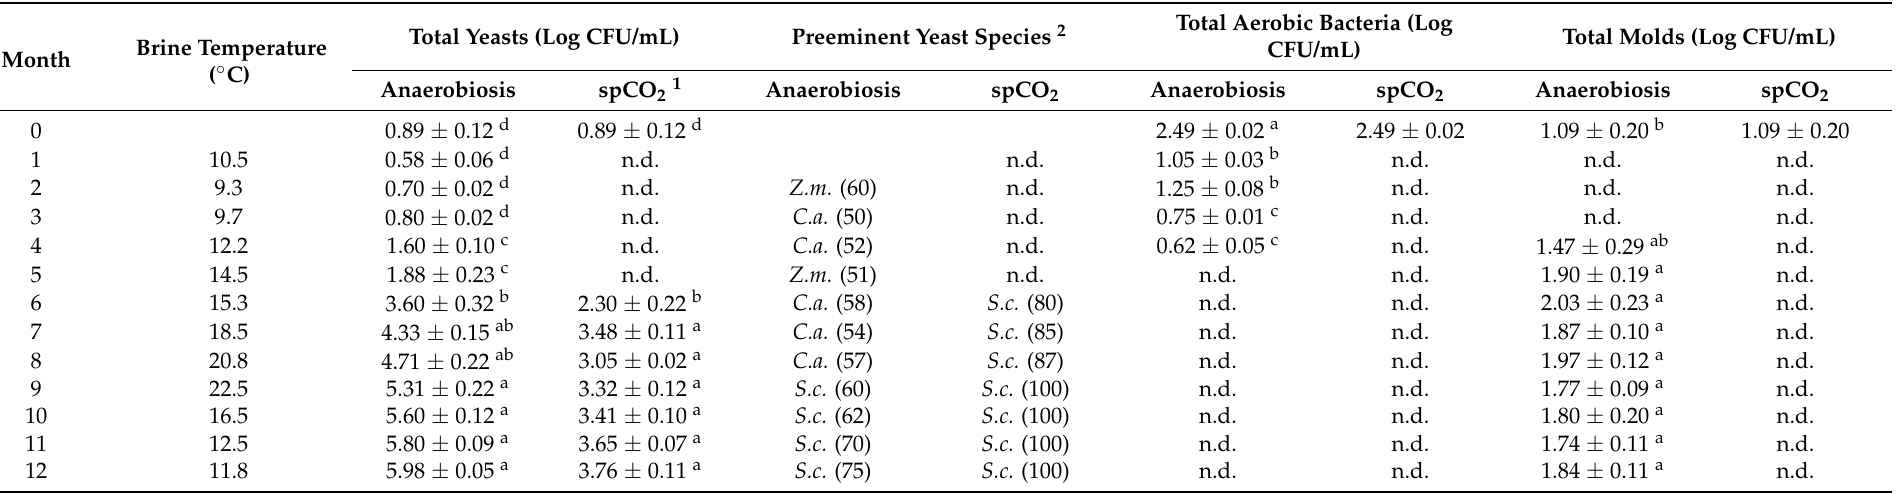
Table 3. Microbial growth in brines of naturally processed Leccino table olives with 5% ( w v − 1 ) NaCl and 0.6% ( w v − 1 ) citric acid during one year of incubation at room temperature in anaerobiosis and slightly pressurized CO 2